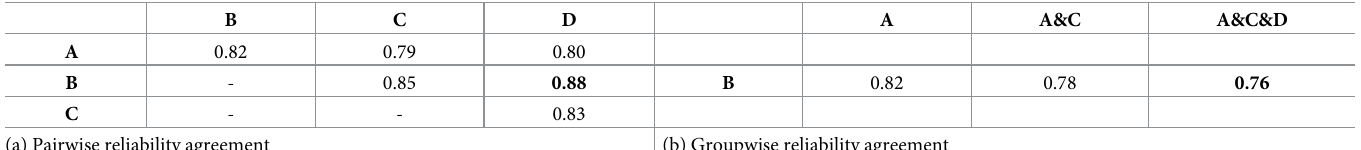
Table 2. Inter-rater reliability agreement using Krippendorff metric. A,B,C,and D are mental healthcare providers as annotators. The annotations provided by MHP “B” showed the highest pairwise agreement and were used to measure incremental groupwise agreement for the robustness in the annotation task. B